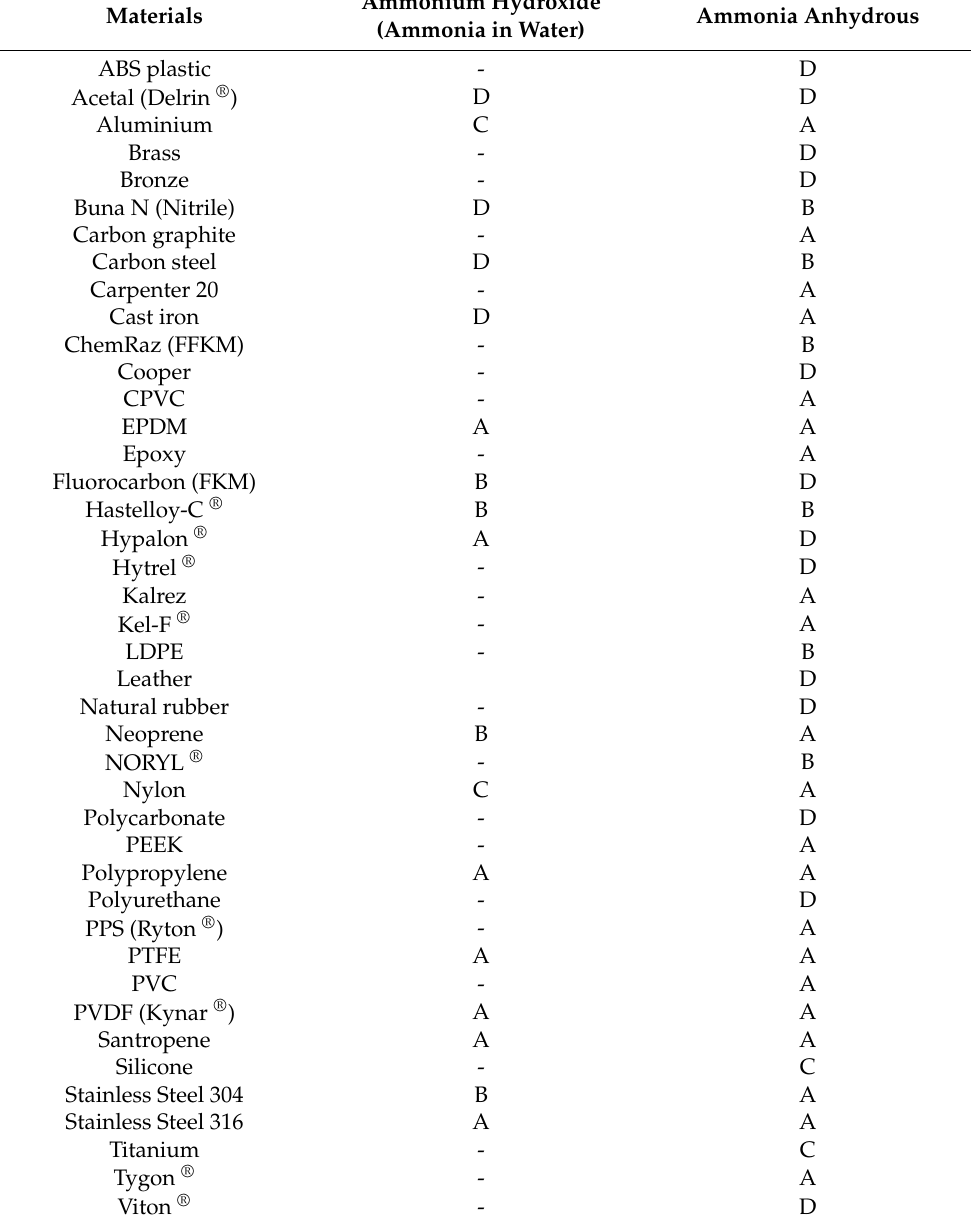
Table 5. Material compatibility of ammonia and its derivative